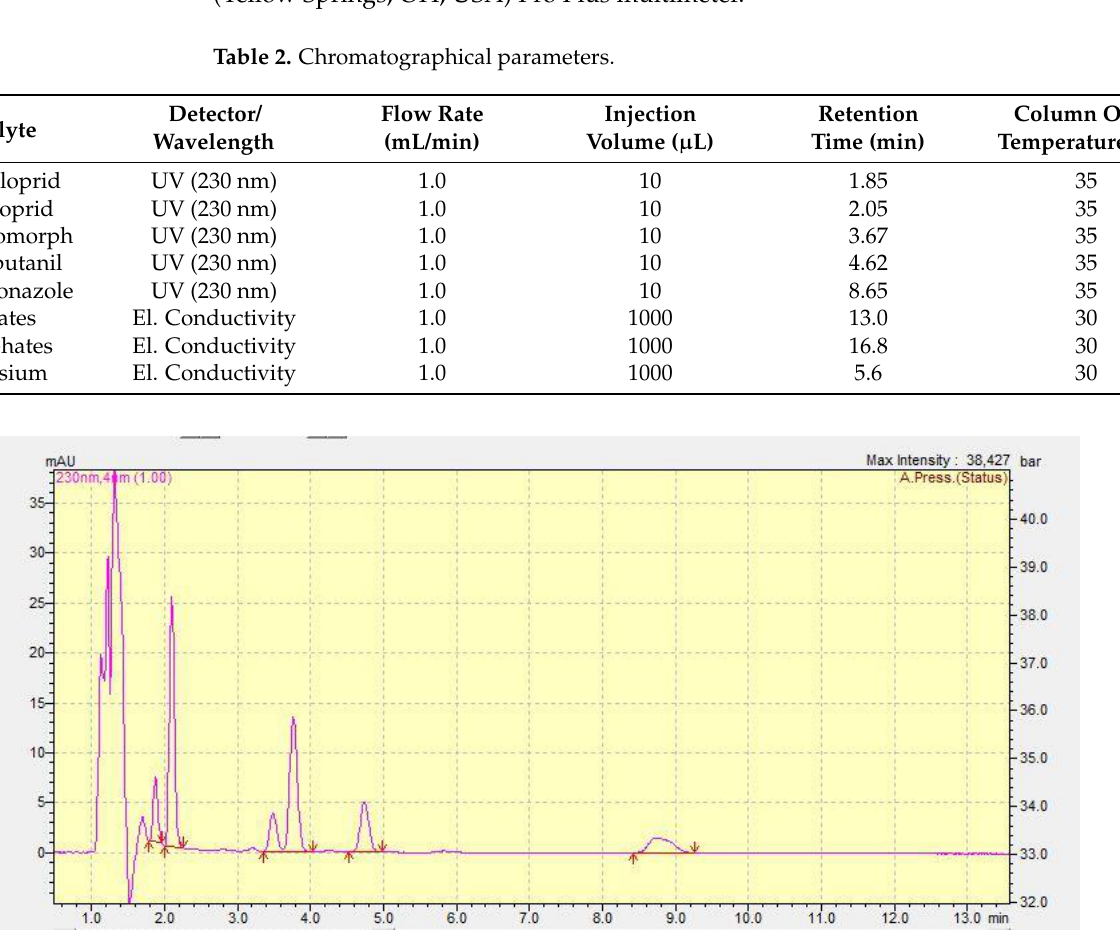
Figure 2. HPLC chromatogram representing the analyte peaks (as reported in Table 2).